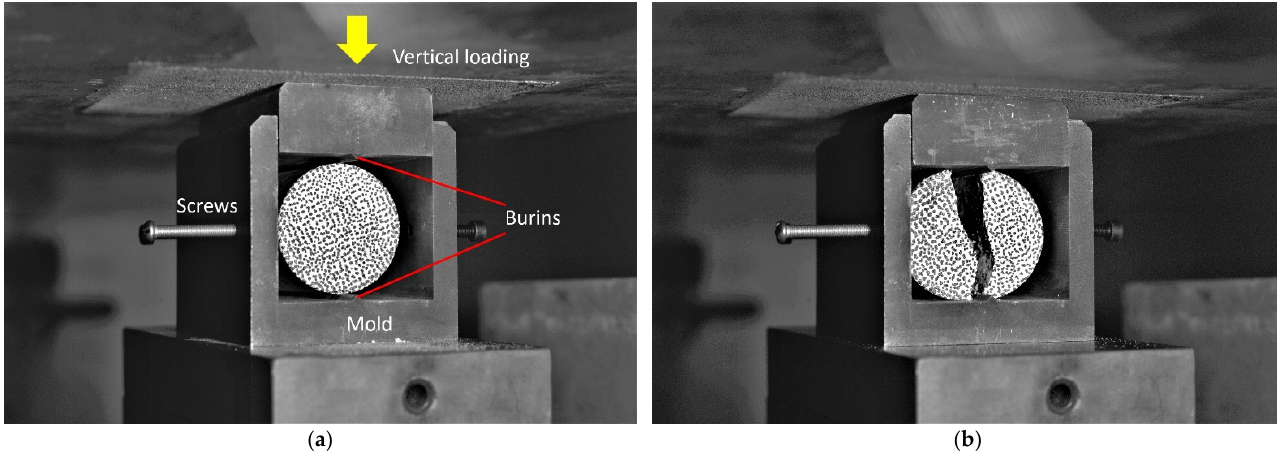
Figure 1. ( a ) Preparation of specimens. ( b ) Two halves of the specimen.